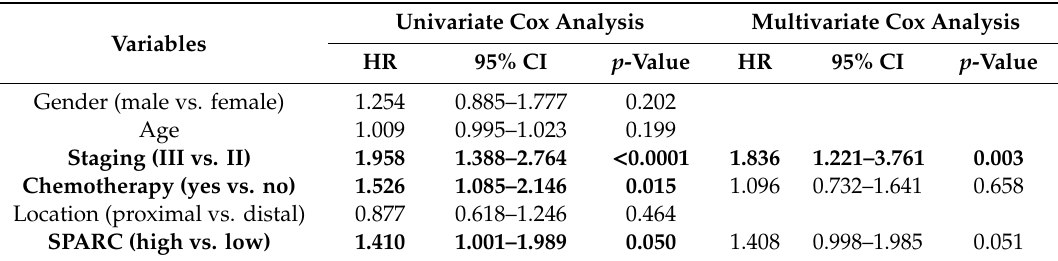
Table 1. Variables a ff ecting 5-year DFS in the mRNA microarray cohort [18].